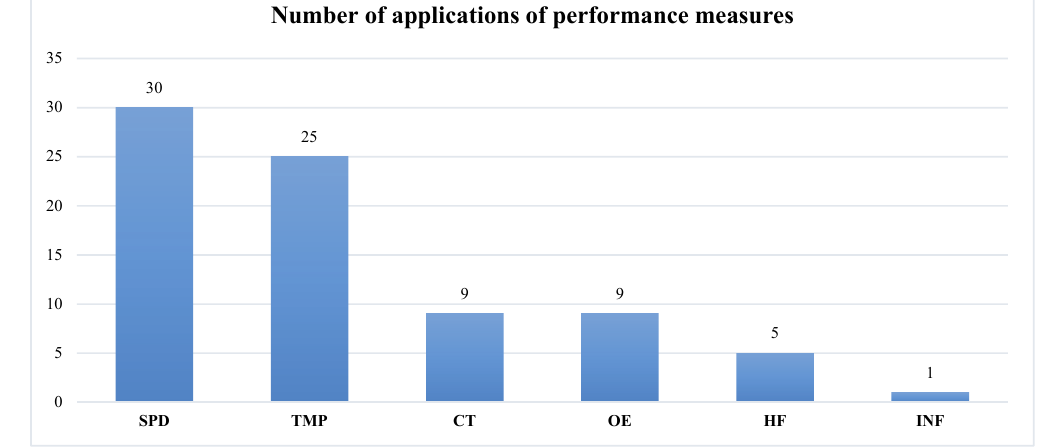
Fig. 14. Distribution of performance